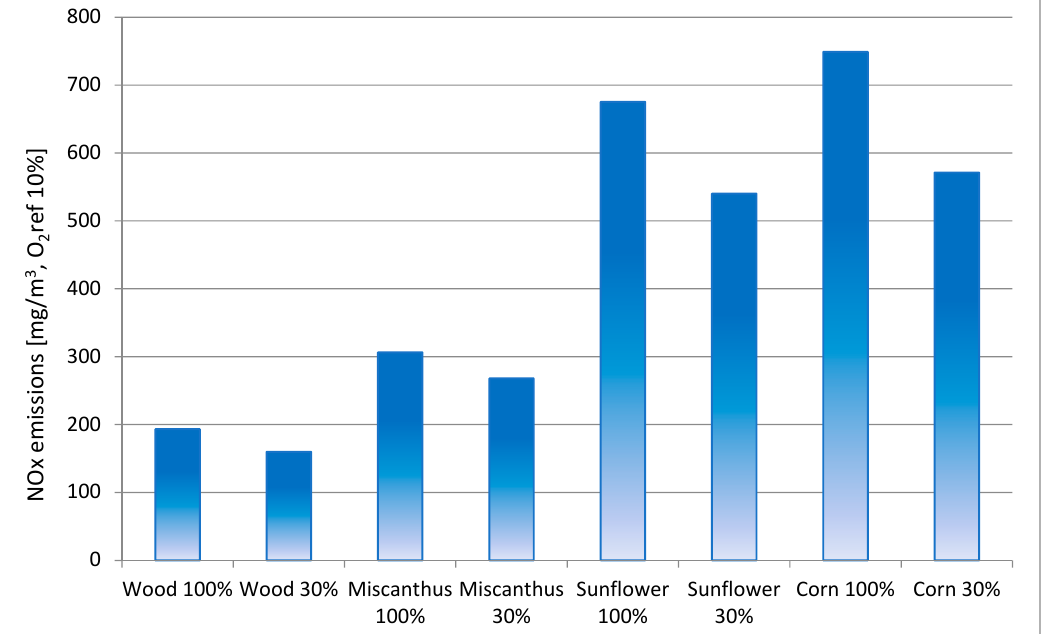
Figure 10. Comparison of NOx emission from different types of pellets.